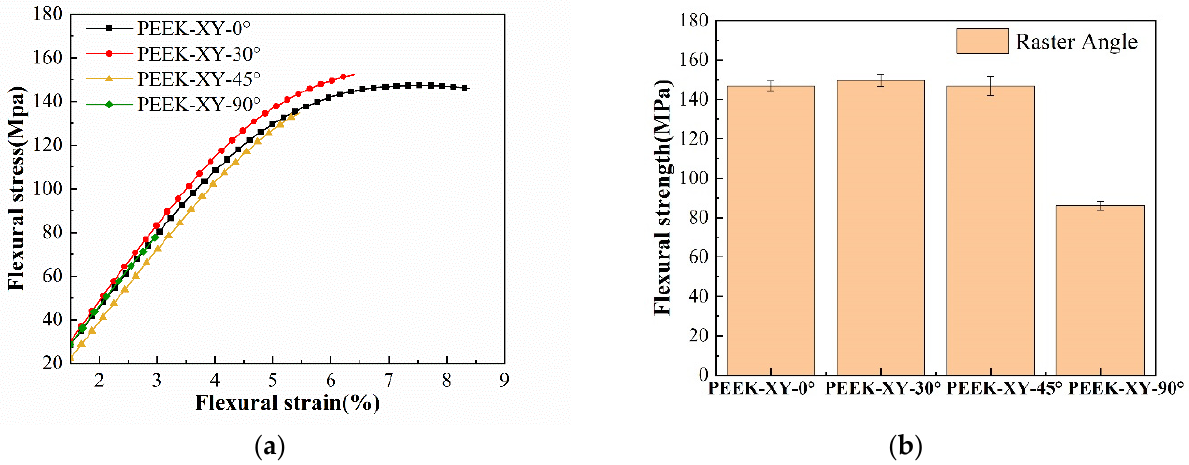
Figure 11. Flexural behaviors with varied raster angles. ( a ) Flexural stress-strain curves; ( b ) average flexural stress against raster angle.